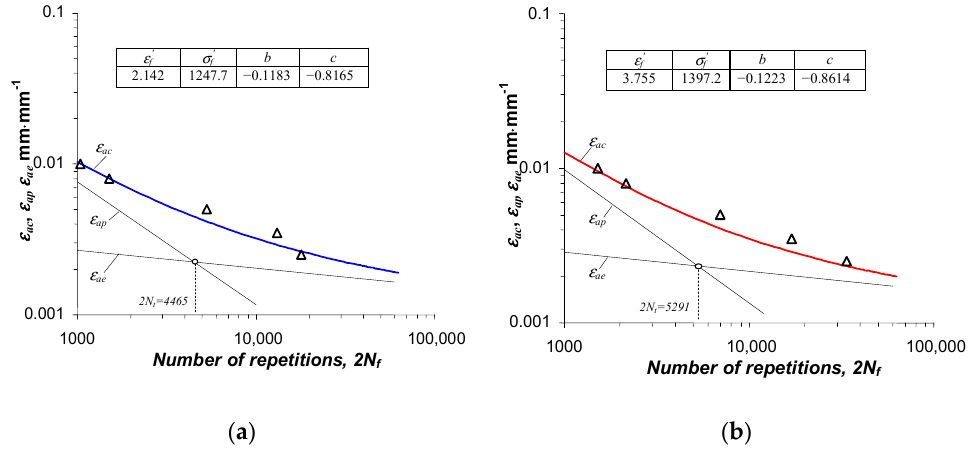
Figure 15. Fatigue graphs: ( a ) as-received specimens, ( b ) pre-strained specimens.